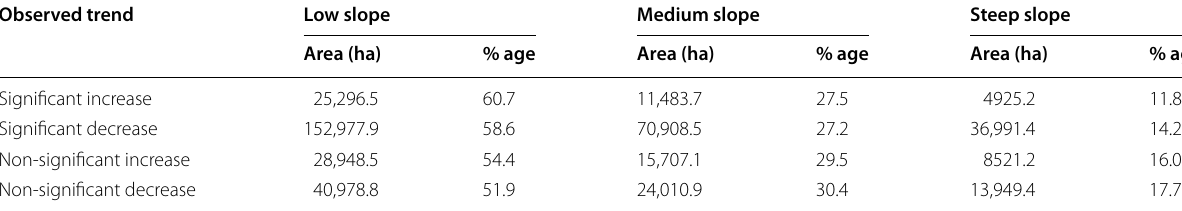
Table 3 Vegetation change across slope gradient Observed trend Low slope Medium slope Steep